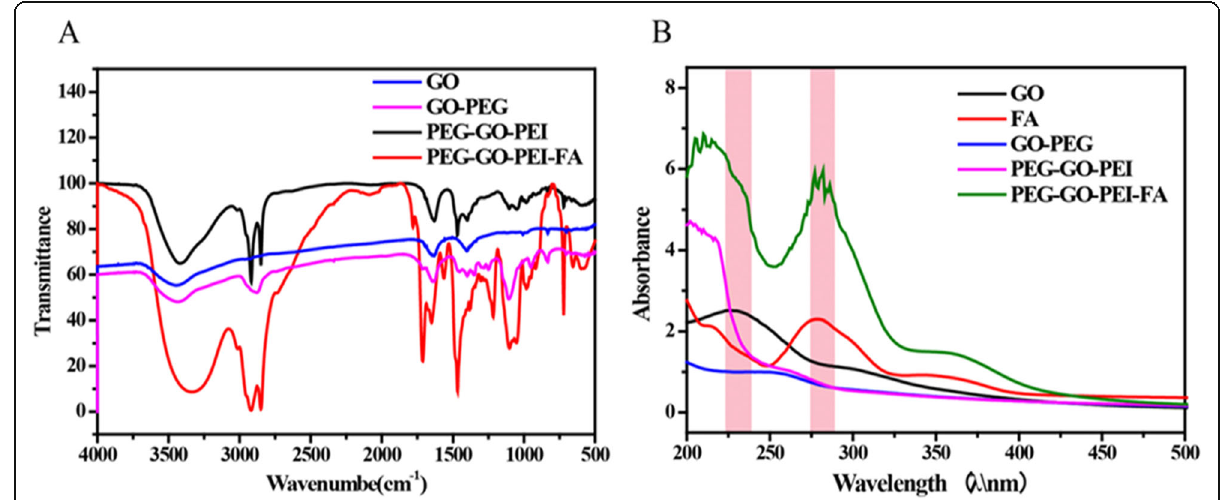
Fig. 1 The successful synthetic analysis of PEG-GO-PEI-FA using Fourier transform infrared spectroscopy (FTIR) and UV-Vis spectrophotometer. a The FTIR spectra of GO, GO-PEG, PEG-GO-PEI, and PEG-GO-PEI-FA. b The UV-Vis absorption spectra of GO, FA, GO-PEG, PEG-GO-PEI, and